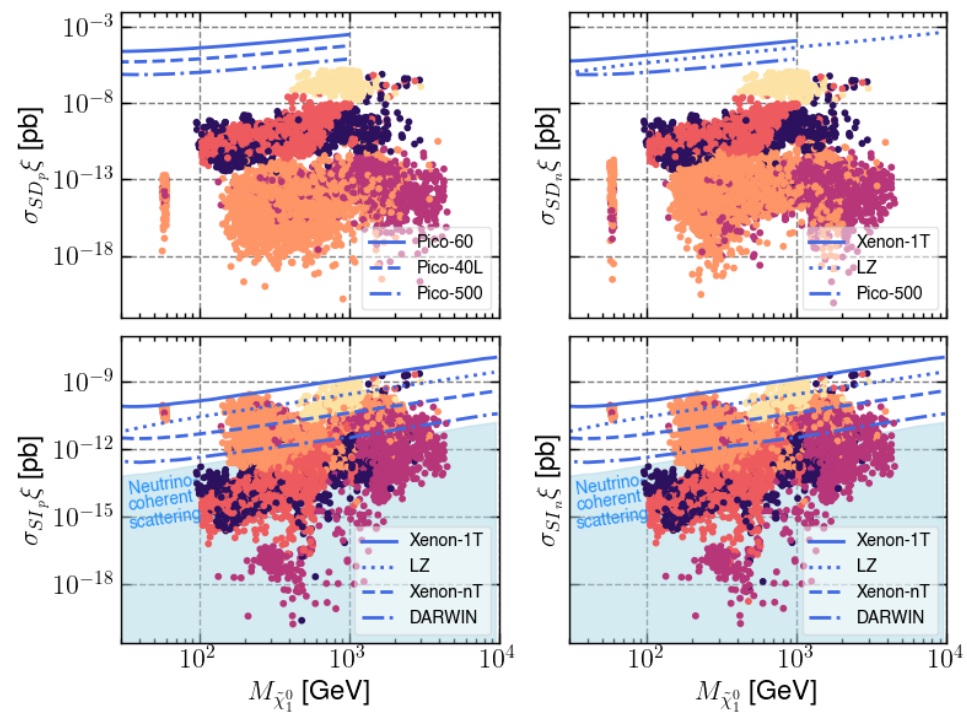
Figure 3: The spin-dependent (top) and spin-independent (bottom) DM cross sec- tions for a target proton (left) or neutron (right) of all non-excluded neutralino LSP solutions as a function of the LSP mass. The cross section is given in units of picobarn (pb) and the mass is given in units of GeV. The tentative limits from LZ are shown in blue in addition to the projected limits from PICO, Xenon-nT, and DARWIN. Fur- thermore, the neutrino-coherent scattering floor is shown in shaded blue. The colour coding for the dominant contribution of the neutralino LSP is the same as in figure